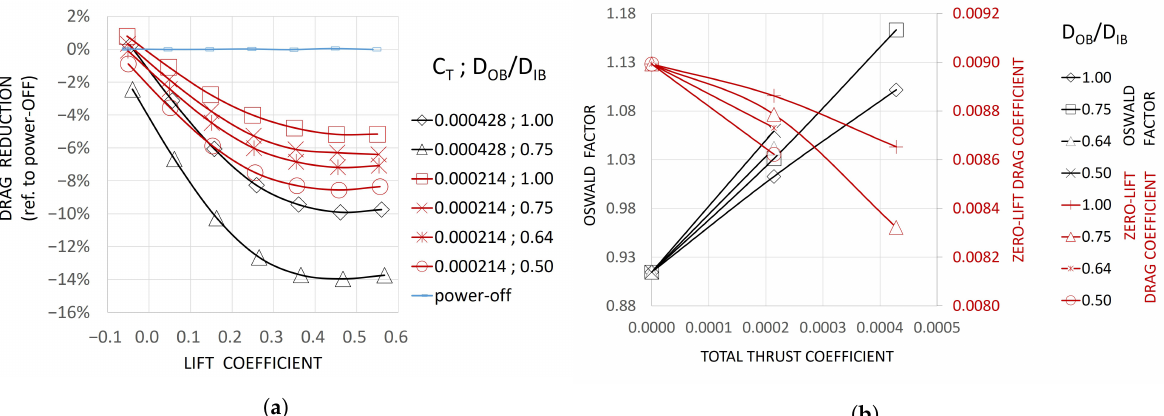
Figure 10. OB propeller effect in cruise conditions ( M = 0.480; Re = 16.6 × 10 6 ): ( a ) Relative drag reduction regarding power-off case (OFF, Table 2); ( b ) Oswald factor and zero-lift drag coefficient.